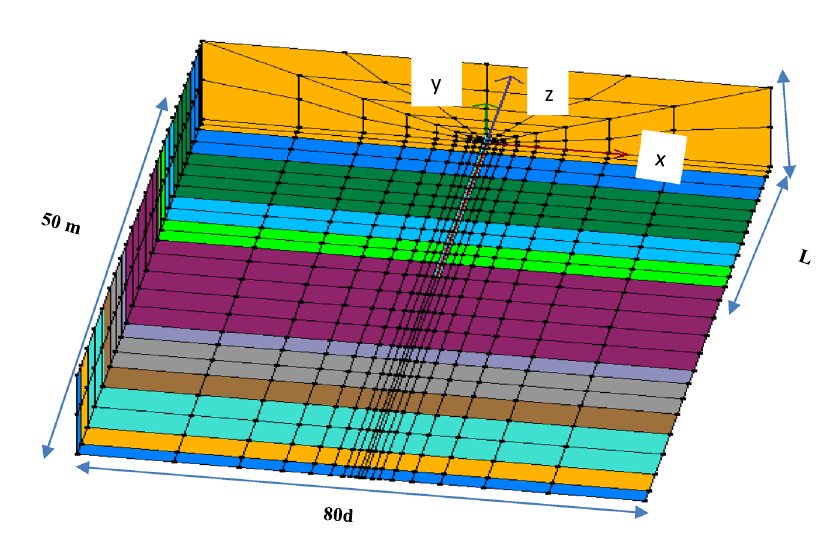
Fig. 2 3D FE model used in the present study